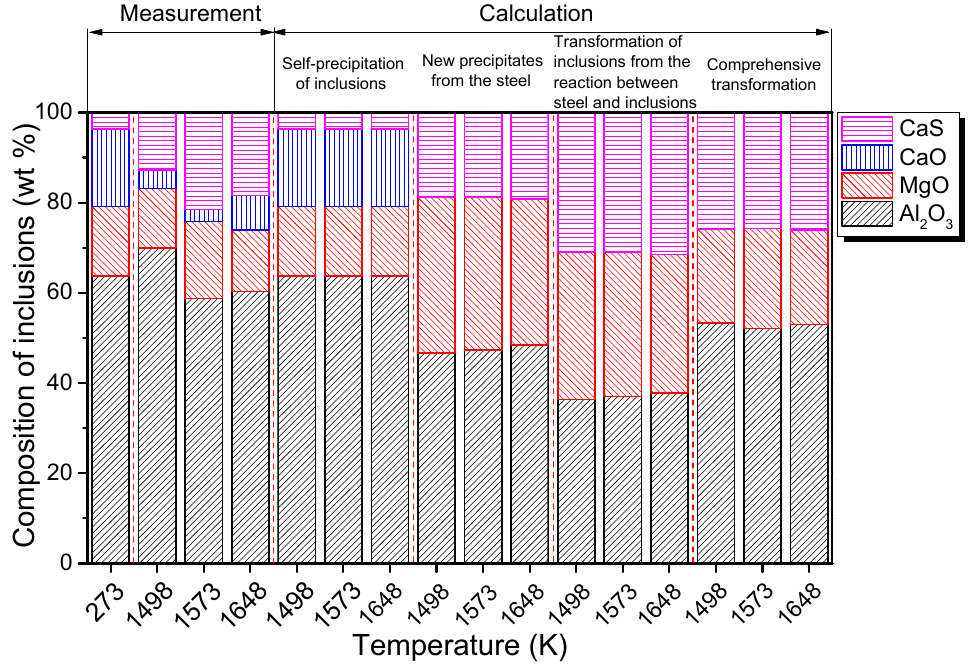
Figure 21. Comparison of experimental results and thermodynamic calculation results with the decrease of temperature.